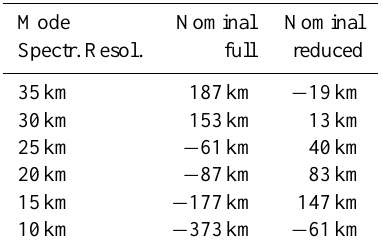
Table 9. Information displacement for CFC-12